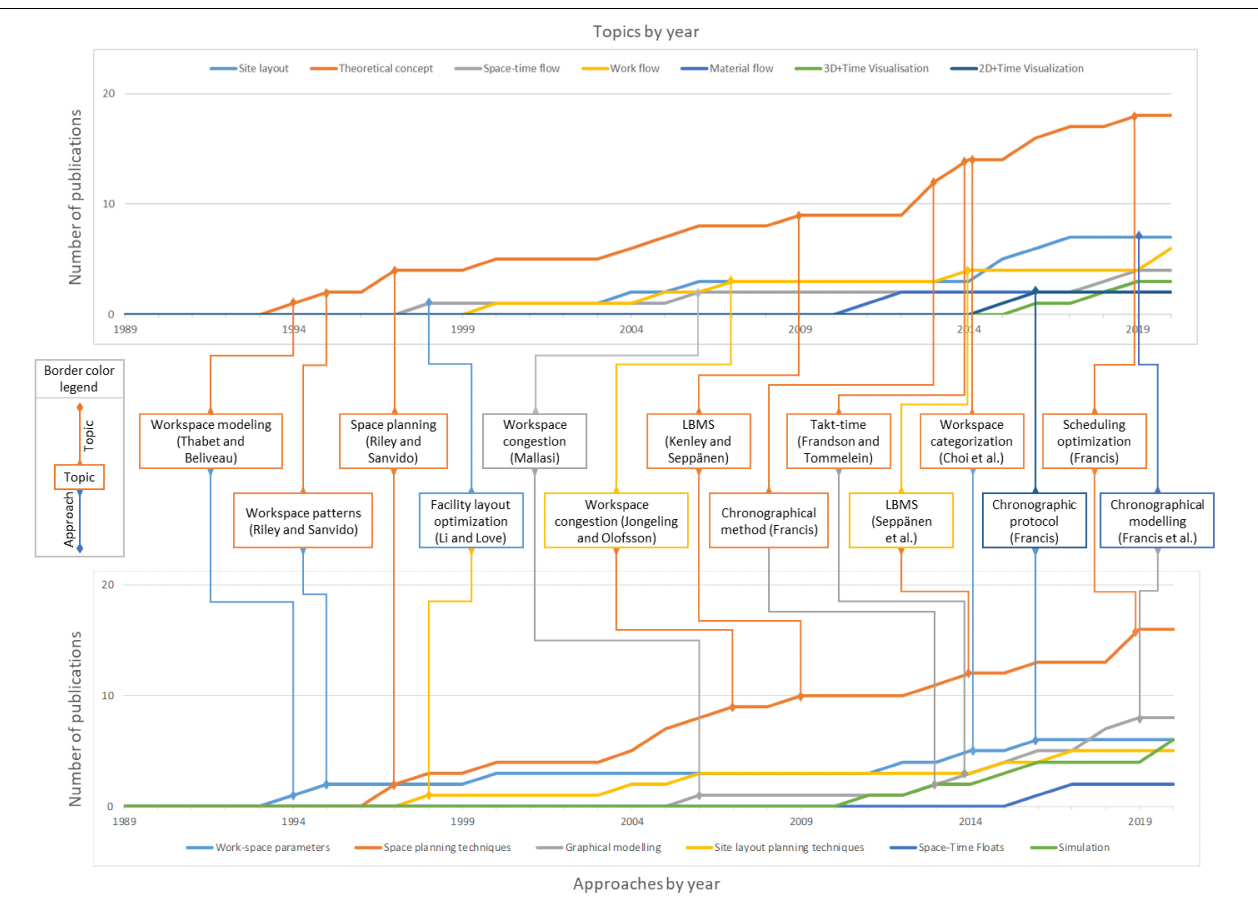
FIGURE 5 | Timeline of research on spatiotemporal planning—Conceptual